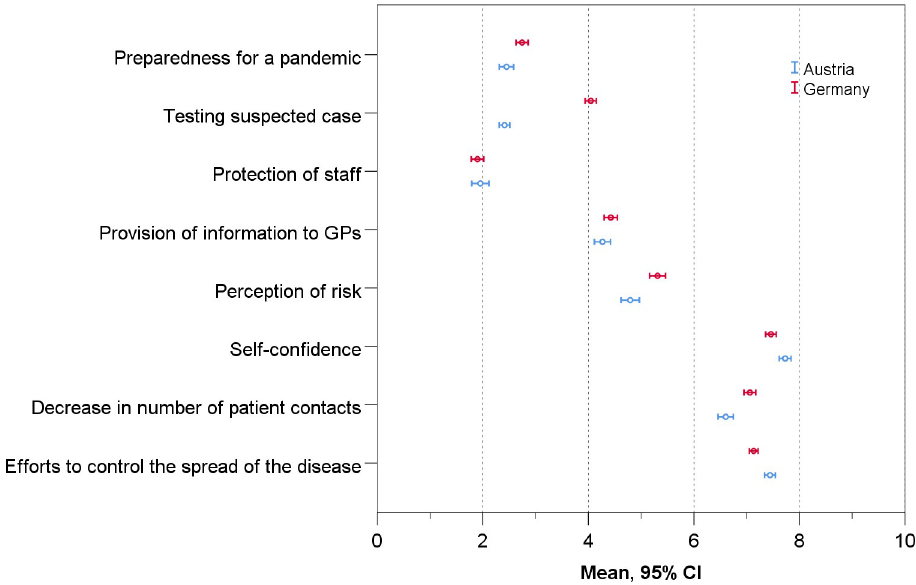
Fig 1. Differences between German and Austrian GPs in their evaluation of the pandemic (Austria: n = 900; Germany: n = 1287).